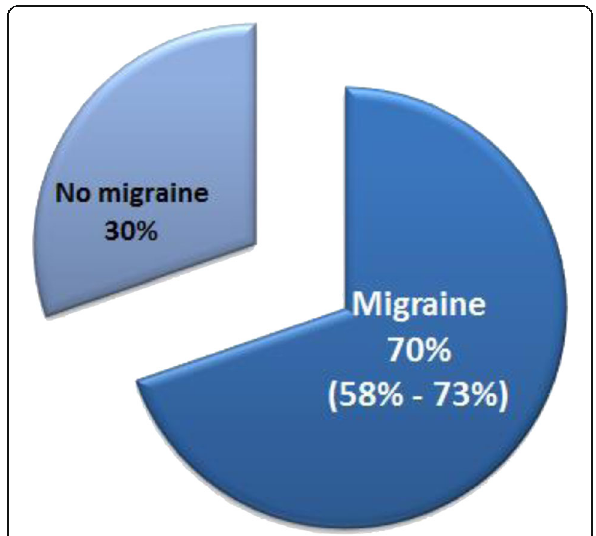
Fig. 1 Proportion (median and range) of patients who developed migraine-like attacks and of patients who did not develop migraine- like attacks after PACAP38 infusion [29, 34,